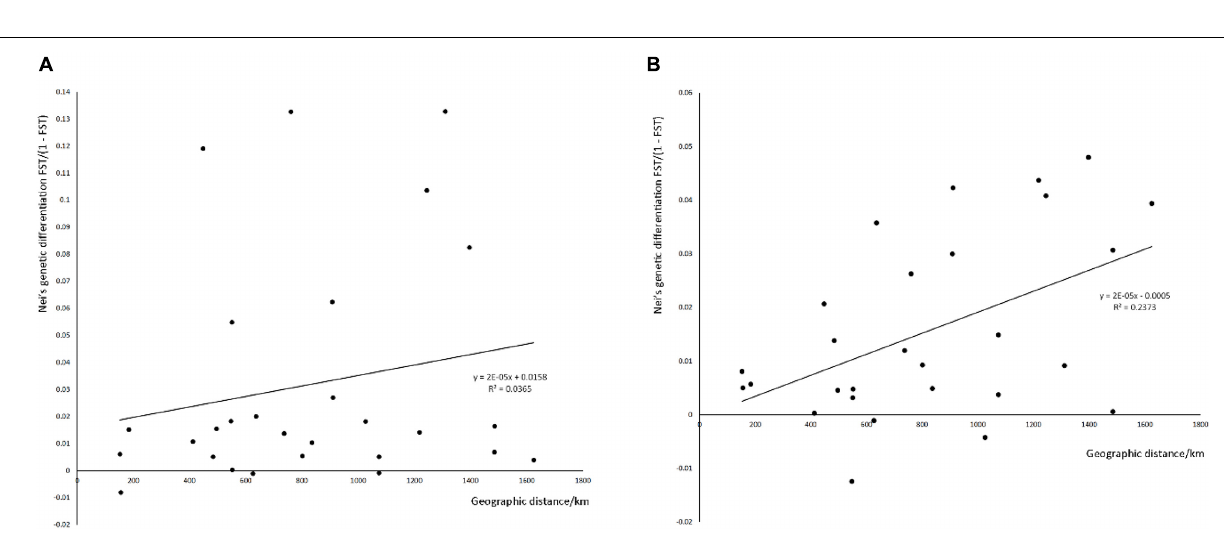
Frontiers in Ecology and Evolution |